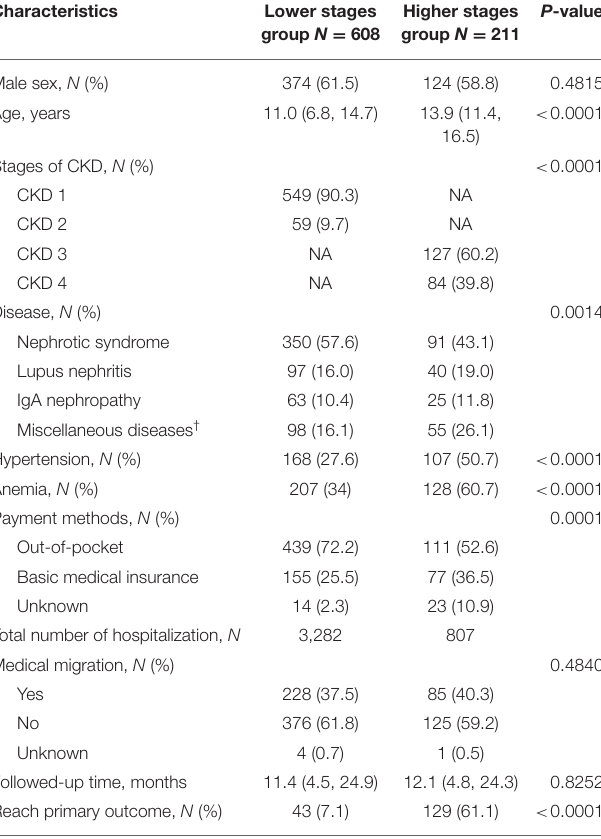
TABLE 1 | Patient characteristics in lower stages group and higher stages group. Characteristics